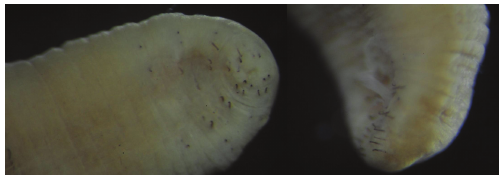
Figure 6: Dark, sharply declinate seta on anterior end of body of the A. peledina from the Chechuj